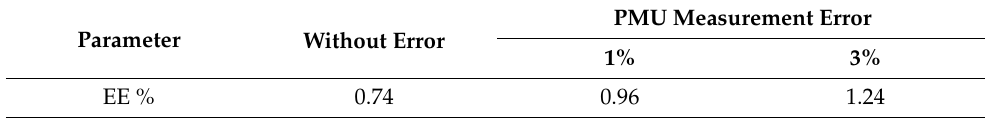
Table 4. Performance sensitivity analysis of the proposed algorithm for PMU measurement error.